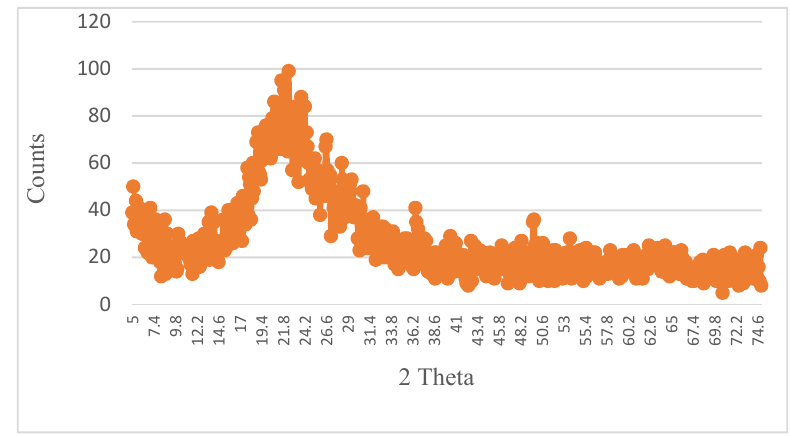
Figure 3. X-ray Diffraction (XRD) pattern of RHA (800 ◦ C—2 h).